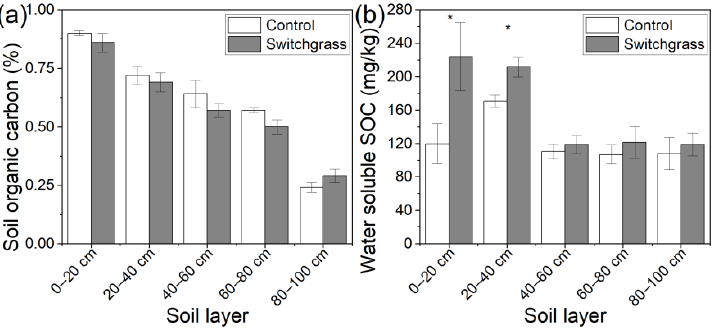
Figure 2. Soil ( a ) organic carbon and ( b ) water-soluble carbon content in bare land (control) and switchgrass-cultivated land. Error bars (standard deviation) were correctly added at the top of the mean columns. A Wilcoxon rank-sum test was used to analyze the significant differences between the bare land and switchgrass cultivated land at p < 0.05 (*).